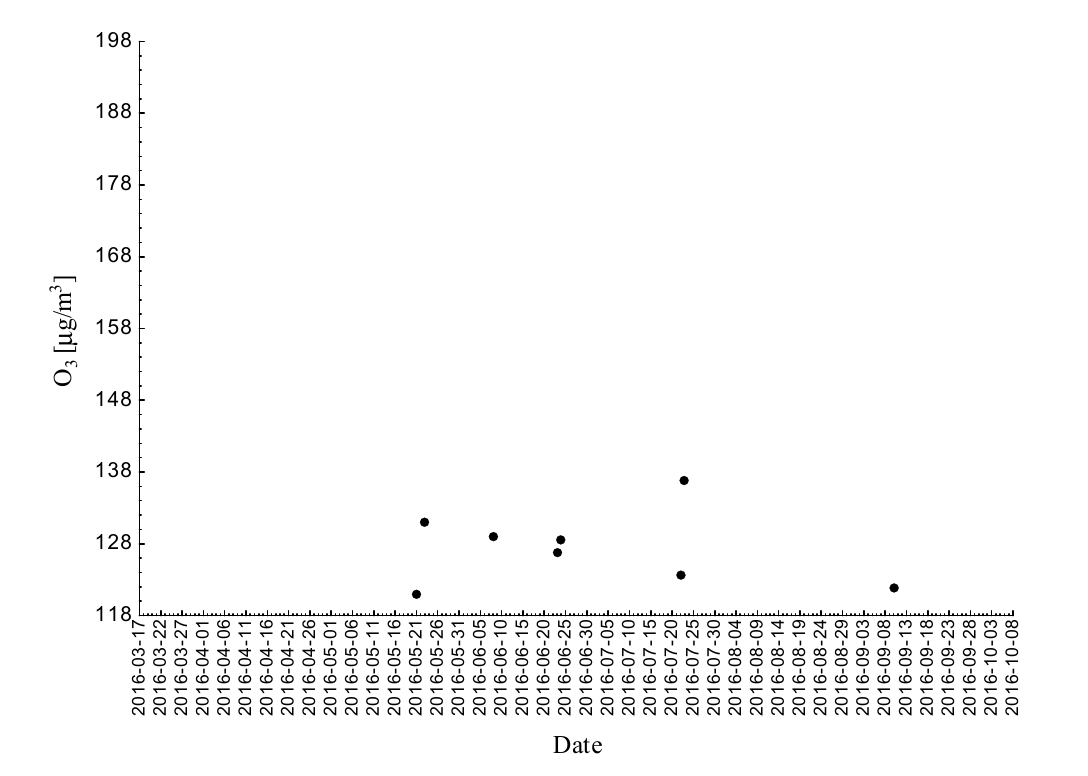
Figure 2. Maximum daily 8-h mean ozone concentration not less (equal to or more than) than 120.4 µg/m 3 registered at the measurement station in Bielsko-Bia ł a (SL15BB) in 2015.